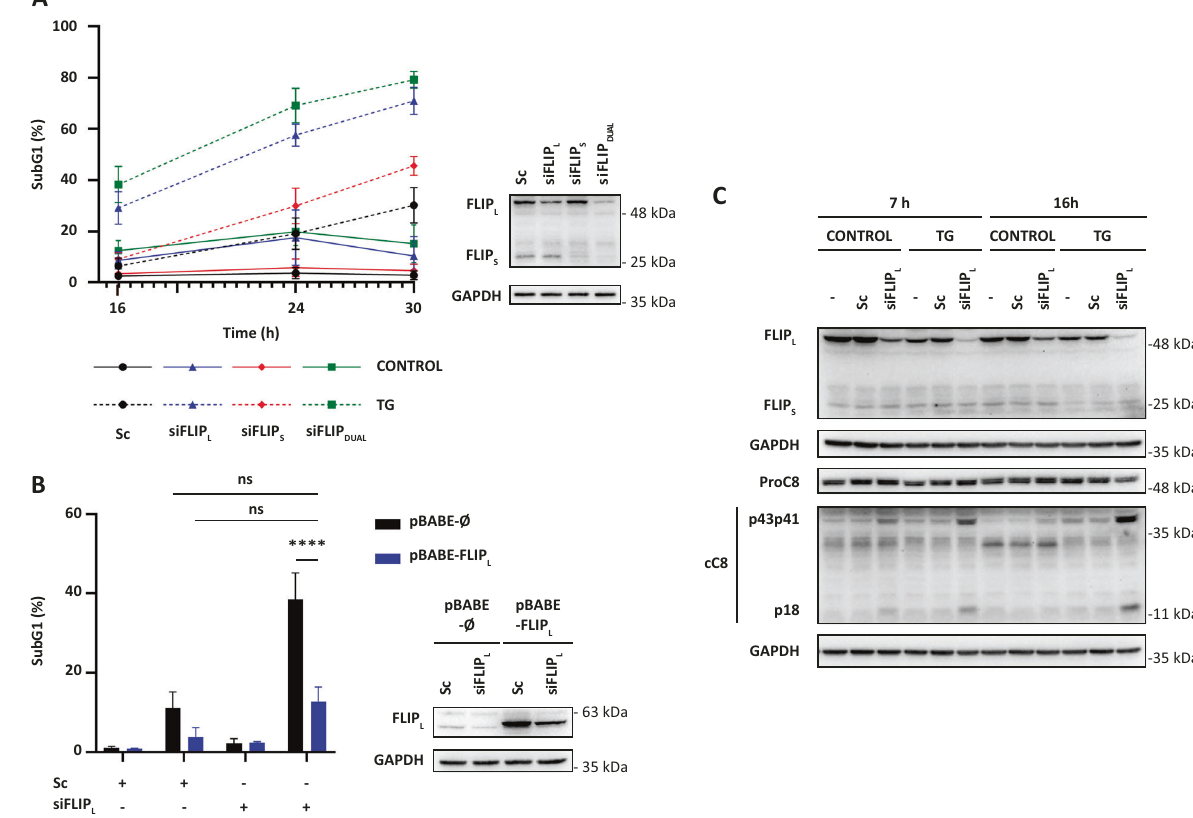
Fig. 4 Effect of cFLIP knockdown on ER stress-induced caspase-8 activation and apoptosis. A HCT116 cells were transfected with scrambled oligonucleotide (Sc) or FLIP L , FLIP S , or FLIP DUAL siRNAs for 48 h prior to TG (100 nM) treatment for the indicated times and apoptosis was determined by subG1 analysis. cFLIP knockdown was assessed in whole-cell extracts by western blotting. GAPDH was used as protein loading control. B HCT116 pBABE-ø or pBABE-cFLIP L cells were transfected for 48 h with scrambled oligonucleotide (Sc) or FLIP L siRNAs and apoptosis was determined after a further 24 h of thapsigargin treatment (ns = not statistically signi fi cant; **** p ≤ 0.0001; two-way ANOVA. Tukey ’ s multiple comparisons test). cFLIP L levels were assessed by western blotting. C HCT116 cells were either non-transfected ( − ) or transfected with scrambled oligonucleotide (Sc) or cFLIP L siRNA for 48 h prior to TG treatment for the indicated times. cFLIP protein levels and caspase-8 processing were determined in whole-cell extracts by western blotting. GAPDH levels were used as protein loading control. Blots are representative of three independent